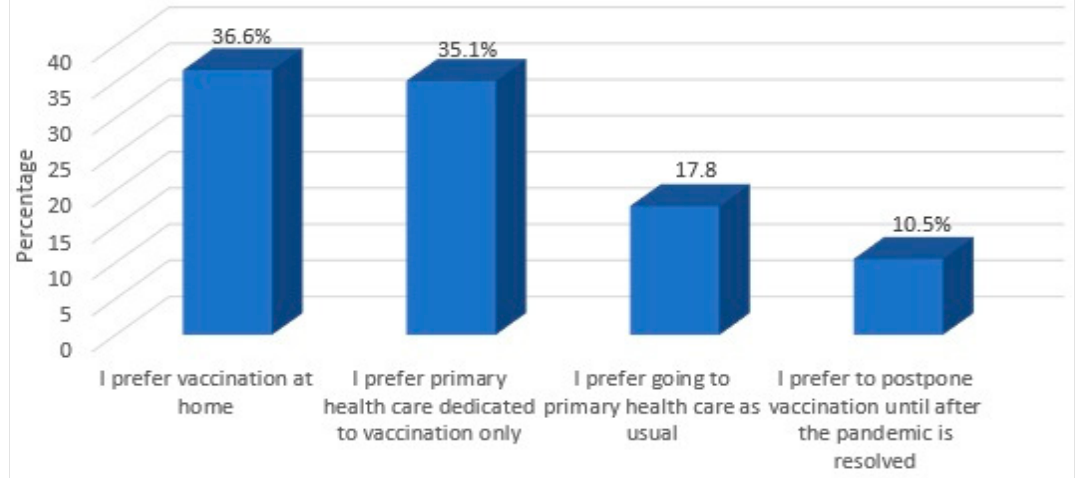
Figure 3. Preferred locale for child vaccination during the pandemic.